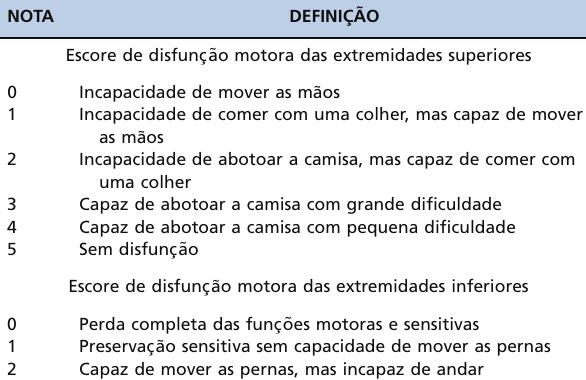
Table 2 - Version of the mJOA scale translated to Portuguese and cross-culturally adapted for the Brazilian population.